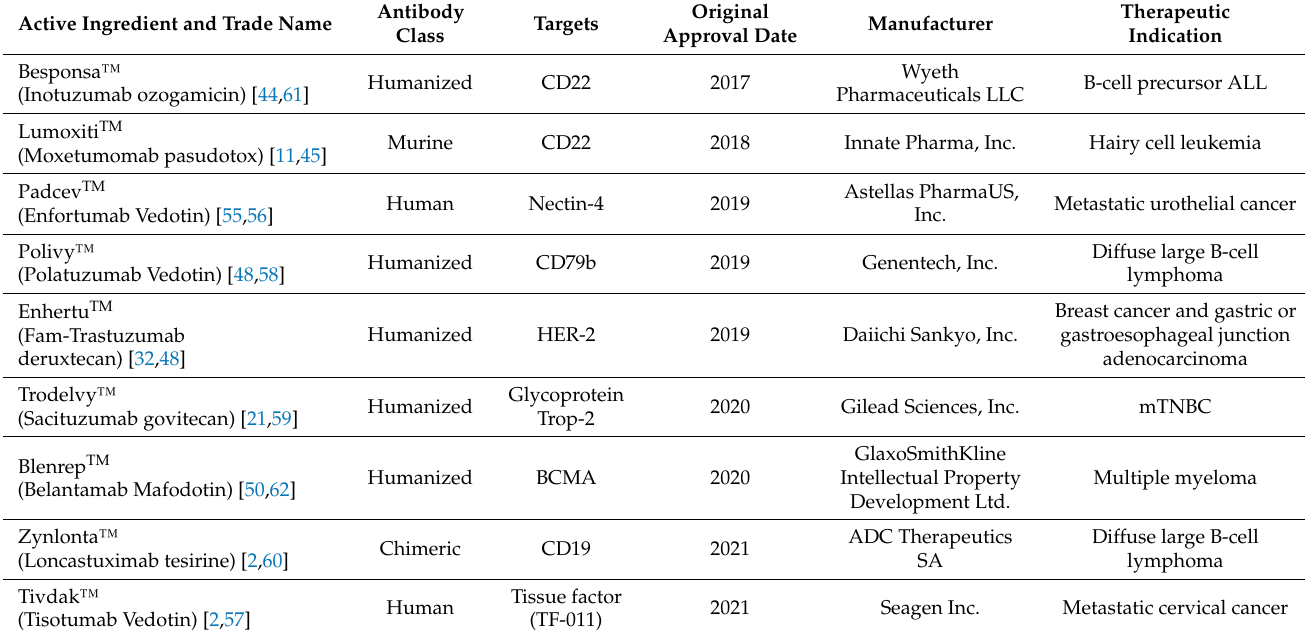
Table 3. Antibody–Drug Conjugates approved by the Food and Drug Administration from 2015 to 2021.